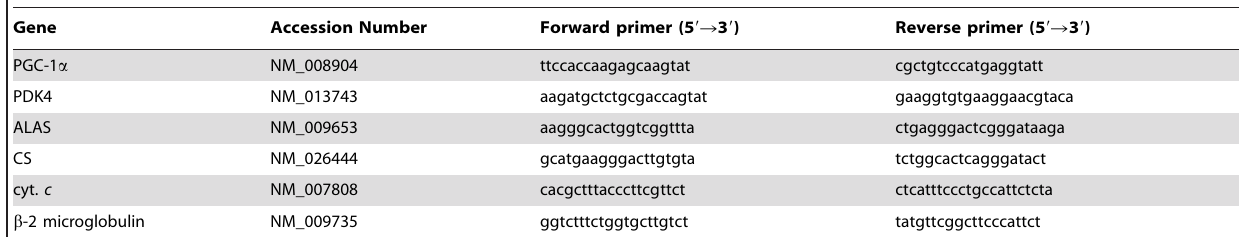
Table 1. Real-time PCR primer